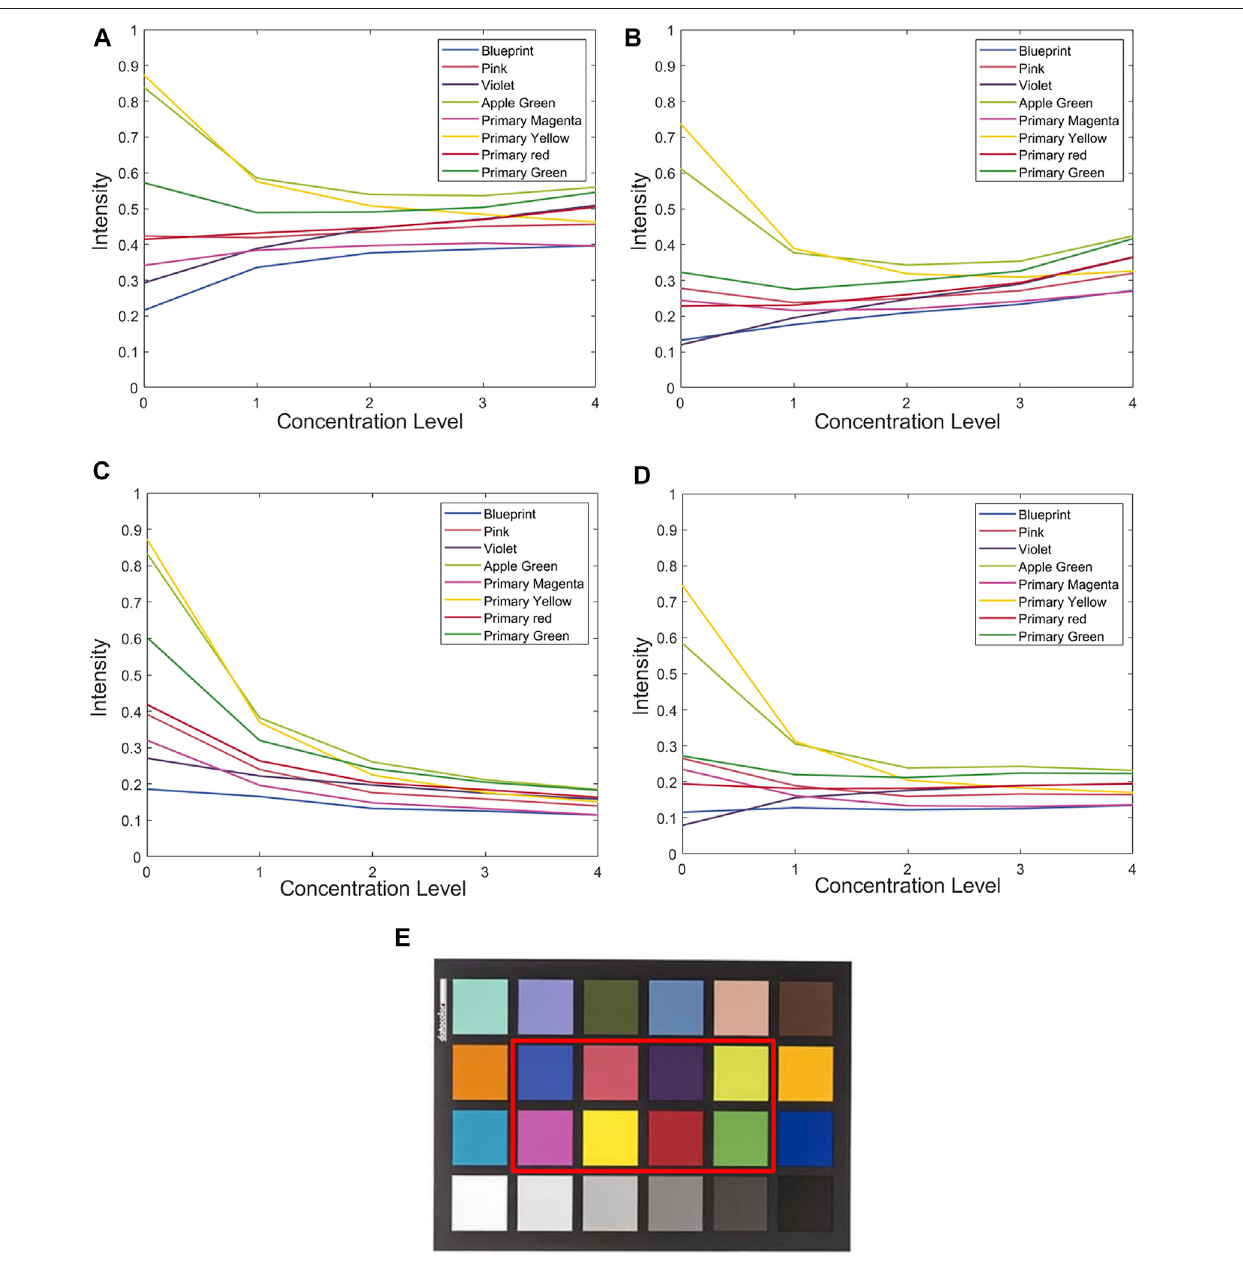
FIGURE11| Theintensityoforthogonalpolarizationchannelsatwithdifferentconcentrations (A) co-polarizedchannel, (B) cross-polarizedchannel, (C) leftcircular polarizedchannel, (D) rightcircularpolarizedchannel, (E) theselectedeightcolorblocksinSpyderCheckr.Theordinateindicatesthenormalizedbackscatteredintensity. The abscissa indicates the concentration level of scattering medium, (level) 0 represents a smoke-free scenario, and (level) 1 – 4 represents a gradual increase of the smoke concentration.